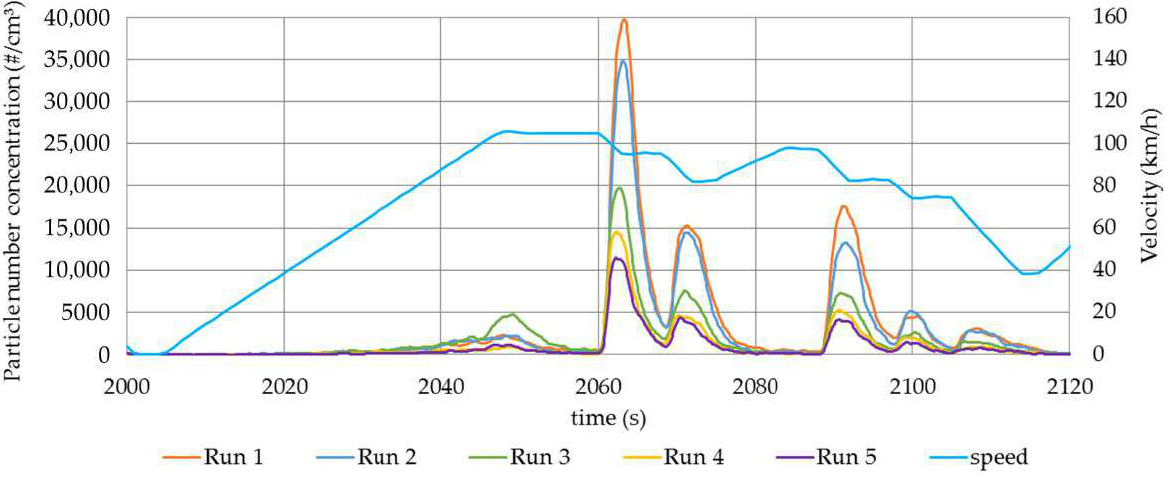
Figure 6. Course of the particle number concentration of a section of trip #10 of the WLTP brake cycle for the first 5 runs (GCI disc—vehicle